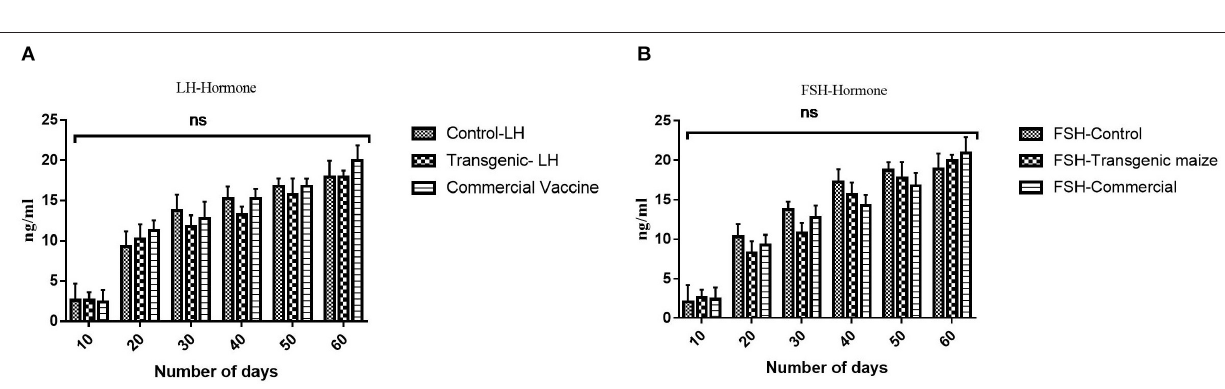
FIGURE 10 | Determination of Sex Hormones. (A) The level of luteinizing hormone in three groups receiving transgenic diet; non-transgenic maize and commercially available vaccines immunized at different time interval (0, 10, 20, 30, 40, 50) were also evaluated to check any disturbance in Luteinizing hormone. No statistically significant difference was observed between three treated groups (B) The level of follicle stimulating hormone in three groups receiving transgenic diet; non-transgenic maize and commercially available vaccines immunized at different time interval (0, 10, 20, 30, 40, 50) were also evaluated to check any disturbance in follicle stimulating hormone. Data shown are average ± SD ( n = 5/group). “ns,” non-significant difference was observed between three treated